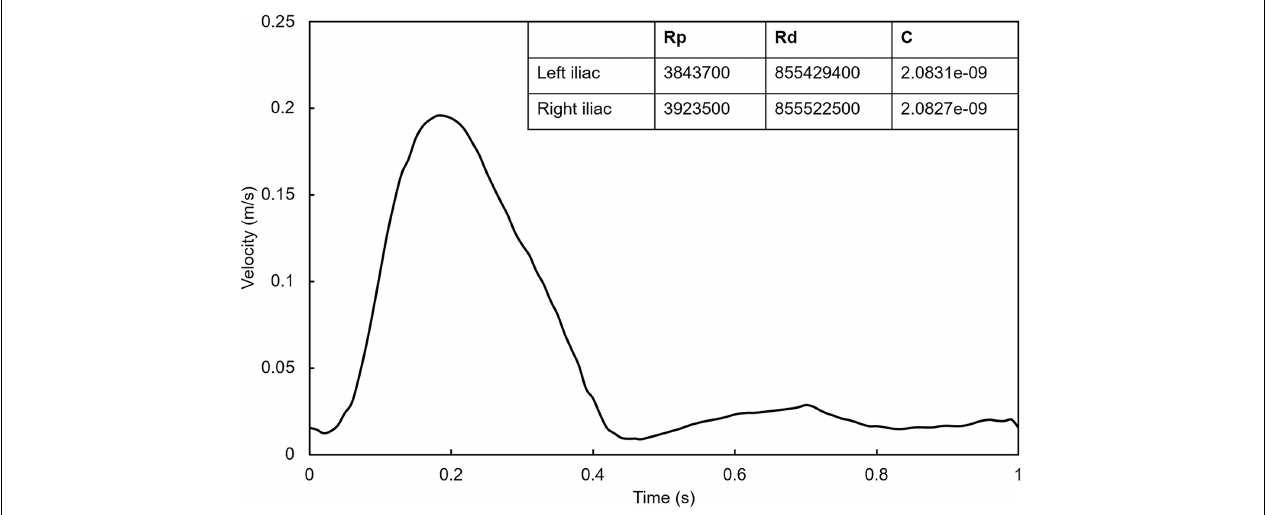
FIGURE 3 | Inlet pulsating velocity waveform. The table in the figure shows the RCR parameters calculated by trial-and-error method at the outlet of left iliac and right iliac.